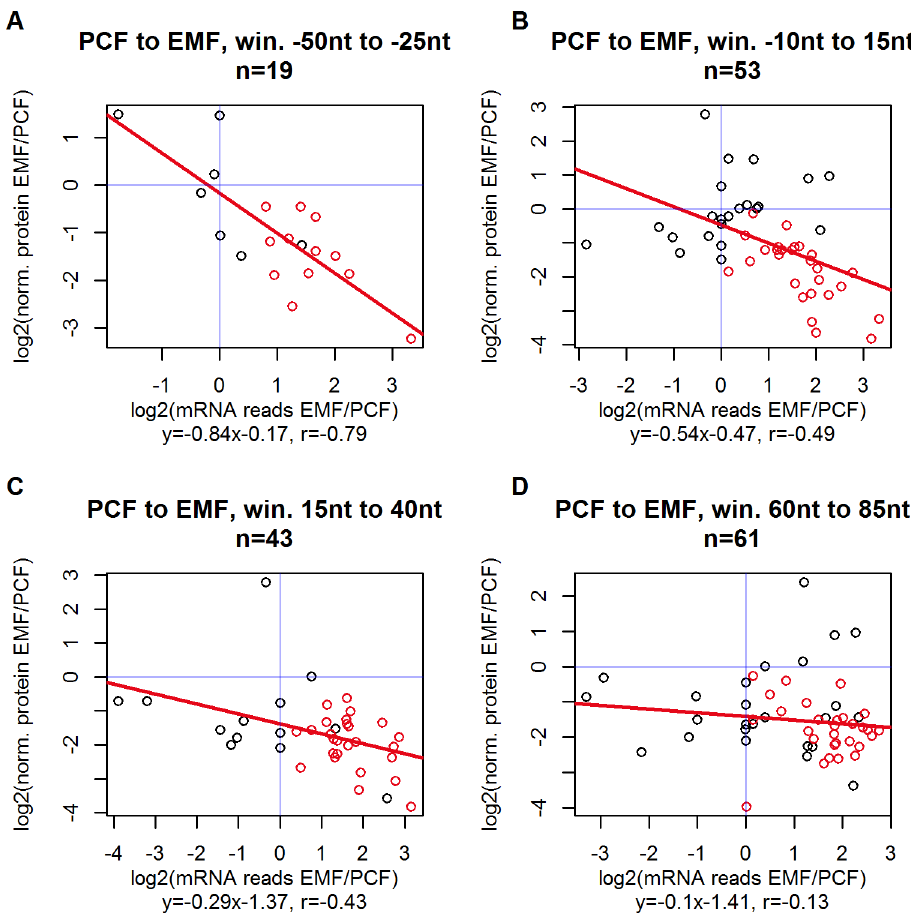
Fig 9. uORFs overlapping CDS mediate the highest repressive potential. During the progression of the life cycle stages, uORFs are cut out or can appear again in the transcriptome due to alternative trans-splicing and might affect translation efficiency depending on their position in 5’ UTR. The example of transition from PCF to EMF is most promising to study the repressive potential of uORFs, since EMF presents the highest absolute level of transcripts and relatively the largest amount of uORF-containing transcripts. The figure presents inter stage changes from PCF to EMF of their respective normalized protein levels (y-axis) and uORF-containing mRNA reads if the respective gene (x- axis). Panels A , B , C and D include transcripts, which contain uORFs with different uORF-to-CDS distance windows. Most scatters are located in the bottom right quadrant, meaning that during the progression from PCF to EMF uORFs are overweighted in the transcriptome and repress translation dose dependently. Red scatters indicate uORFs that are consecutively underrepresented in MCF and release translation repression again (see Fig 10). The regression lines slope can be employed as a measure, how effective overweighting a uORF correlates to protein output control. ( A ) In general, overlapping uORFs score the highest repression efficiency. ( B , C , D ) The uORF’s repressive potential decreases with increasing uORF to CDS